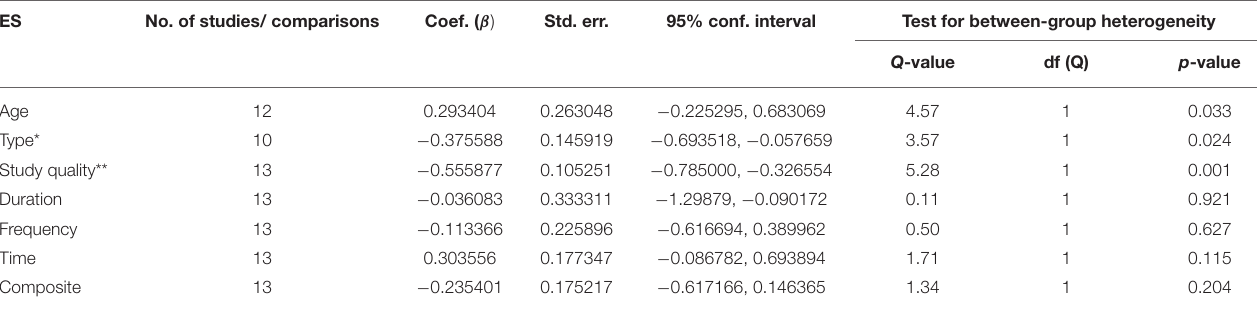
TABLE 8 | Regression analysis for chronic exercises vs. the control group of working